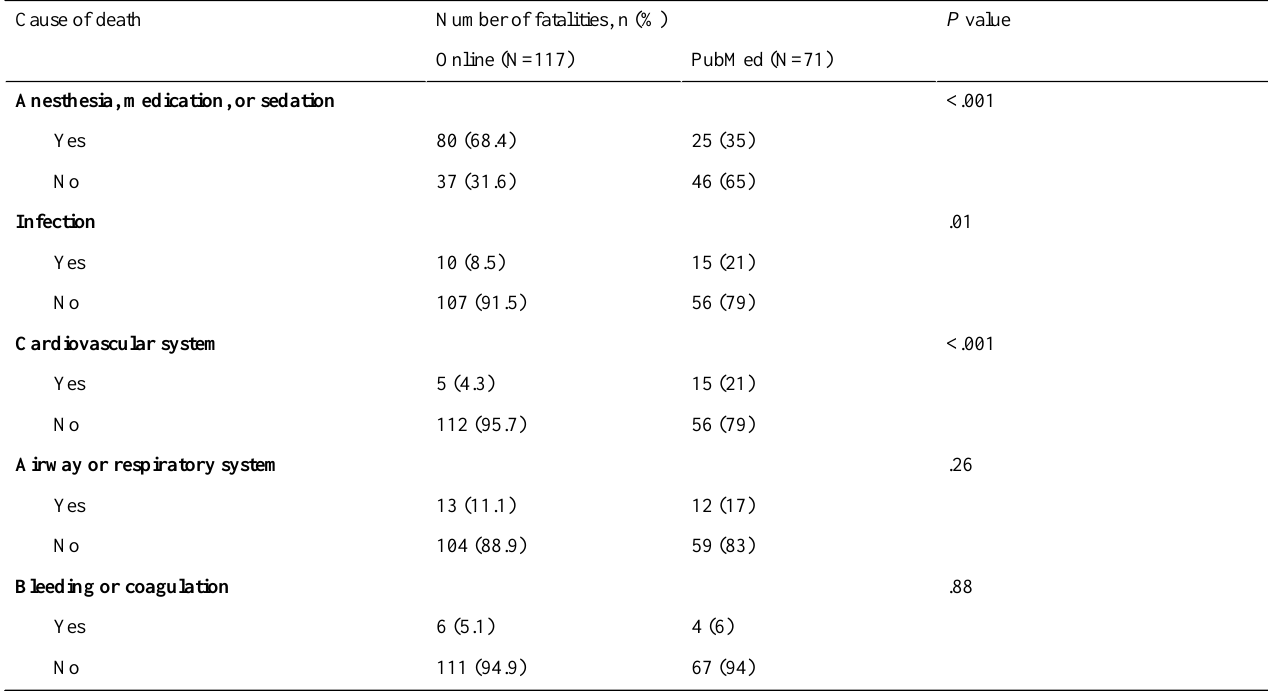
Table 7. Comparison of fatalities reported in online and PubMed publications with respect to causes of